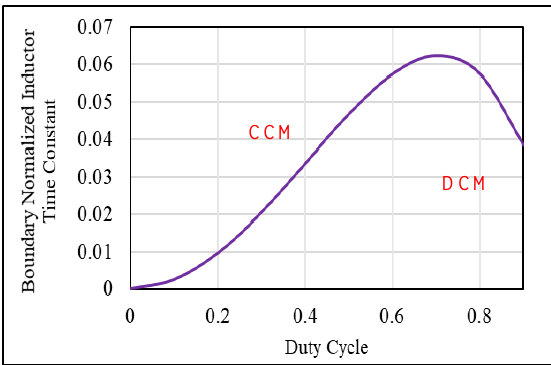
Figure 3. Boundary between CCM and DCM mode of operation.